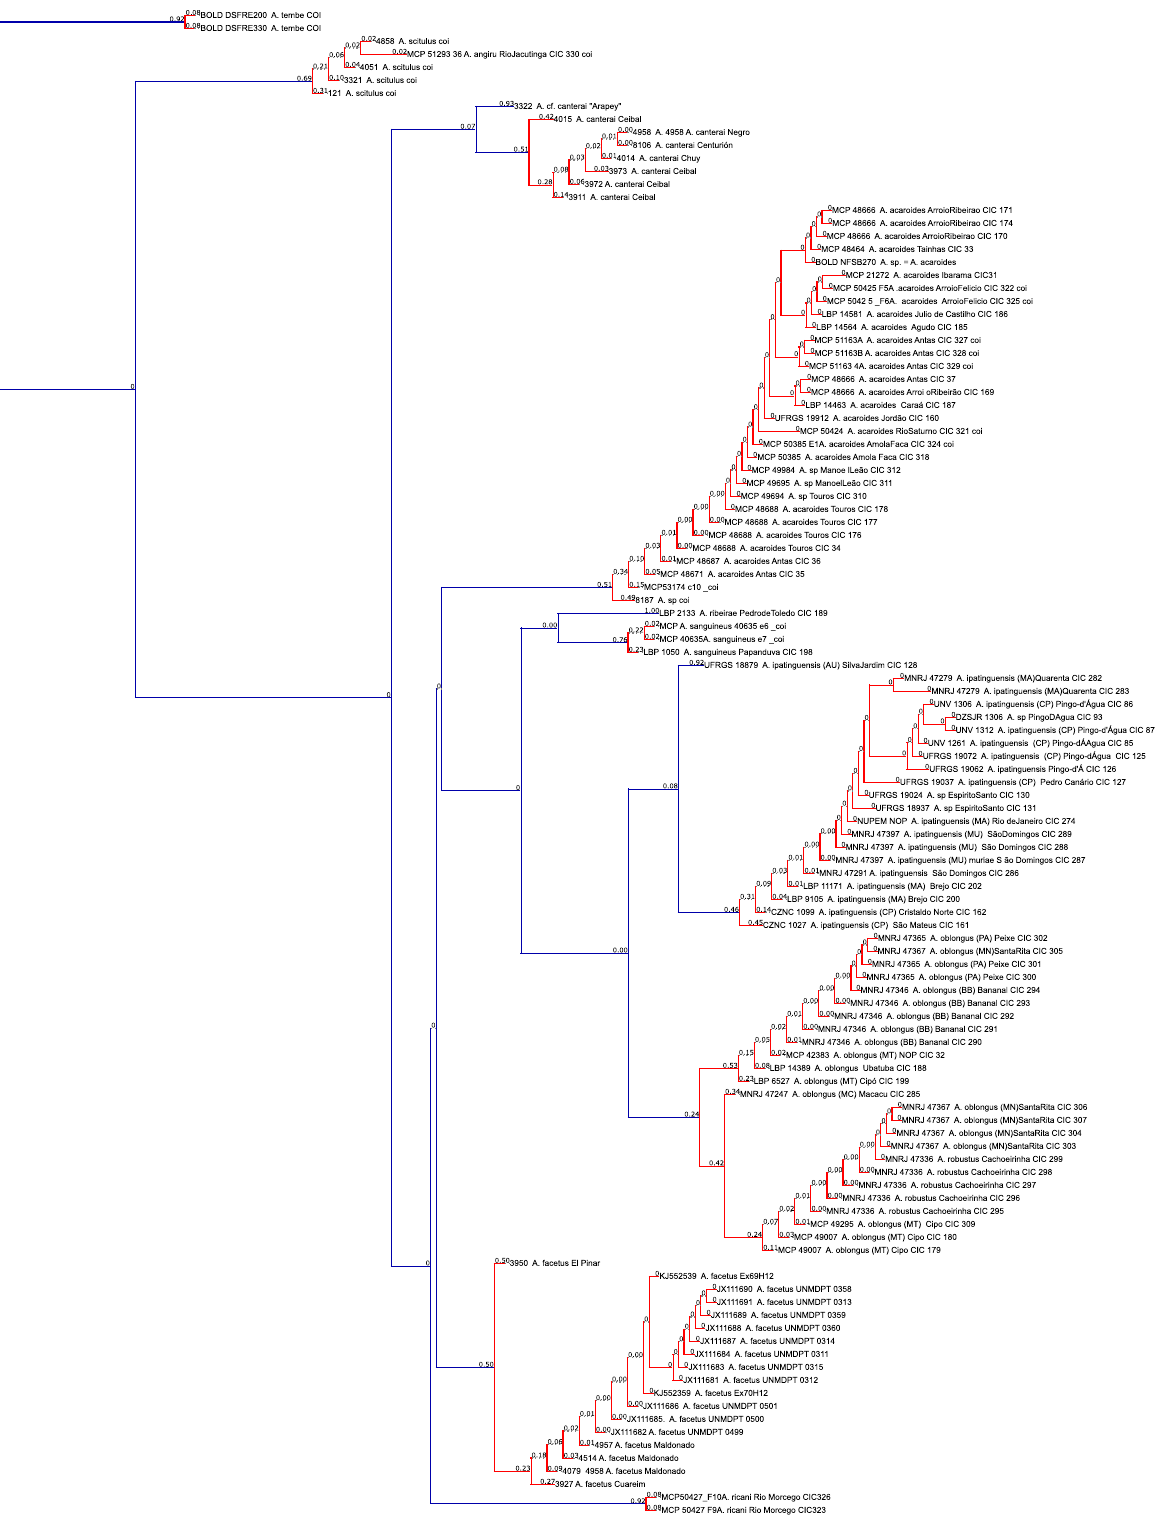
Fig 10. Delimitation of species of Australoheros based on bPTP analysis of mt-coI sequences. Blue lines lead to suggested species; red lines combine within-species branches. Node numbers are percentage support values generated by bPTP. OTU names are as those considered as valid species;